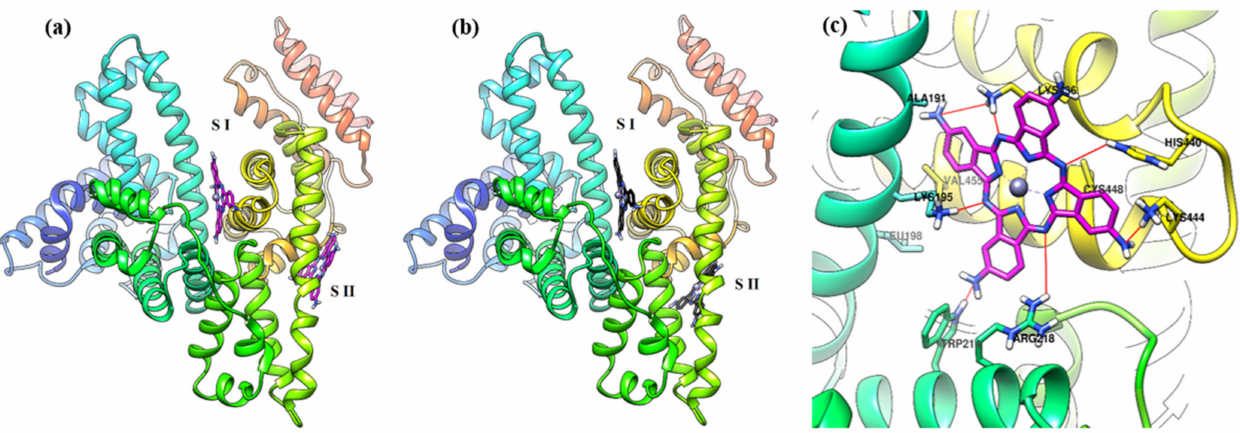
Figure 4. Graphic representation of the binding poses predicted for phthaloNH2 into the two Sudlow’s sites (S I and S II). The top conformations predicted by AutoDock are presented in the left side ( a ), with magenta colorization of the carbon atoms. The top conformations predicted by AutoDock vina are presented in the right side ( b ), with black colorization of the carbon atoms. The domains of albumin are colored the same between the two representations ( a , b ). The pose with the highest affinity of phthaloNH 2 into Sudlow’s site I, with the depiction of interactions with the amino acid residues ( c